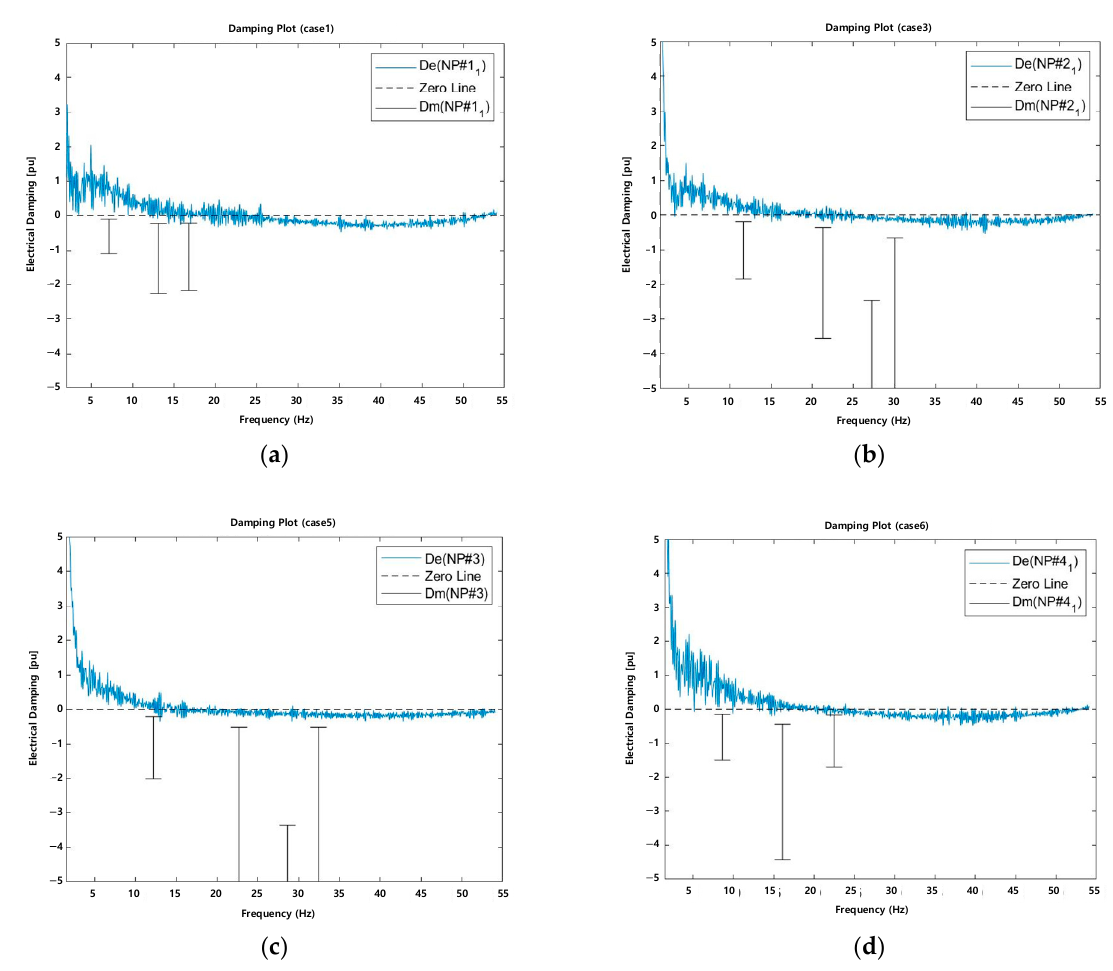
Figure 10. Damping analysis results of generators capable of running in series. ( a ) Case1 NP#1_1 Generator damping analysis result. ( b ) Case3 NP#2_1 Generator damping analysis result. ( c ) Case5 NP#3 Generator damping analysis result. ( d ) Case6 NP#4_1 Generator damping analysis result.